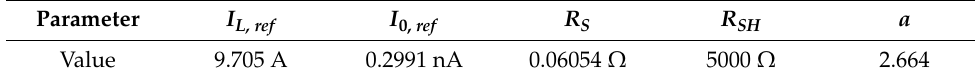
Table 3. Values for the five-parameter model used in